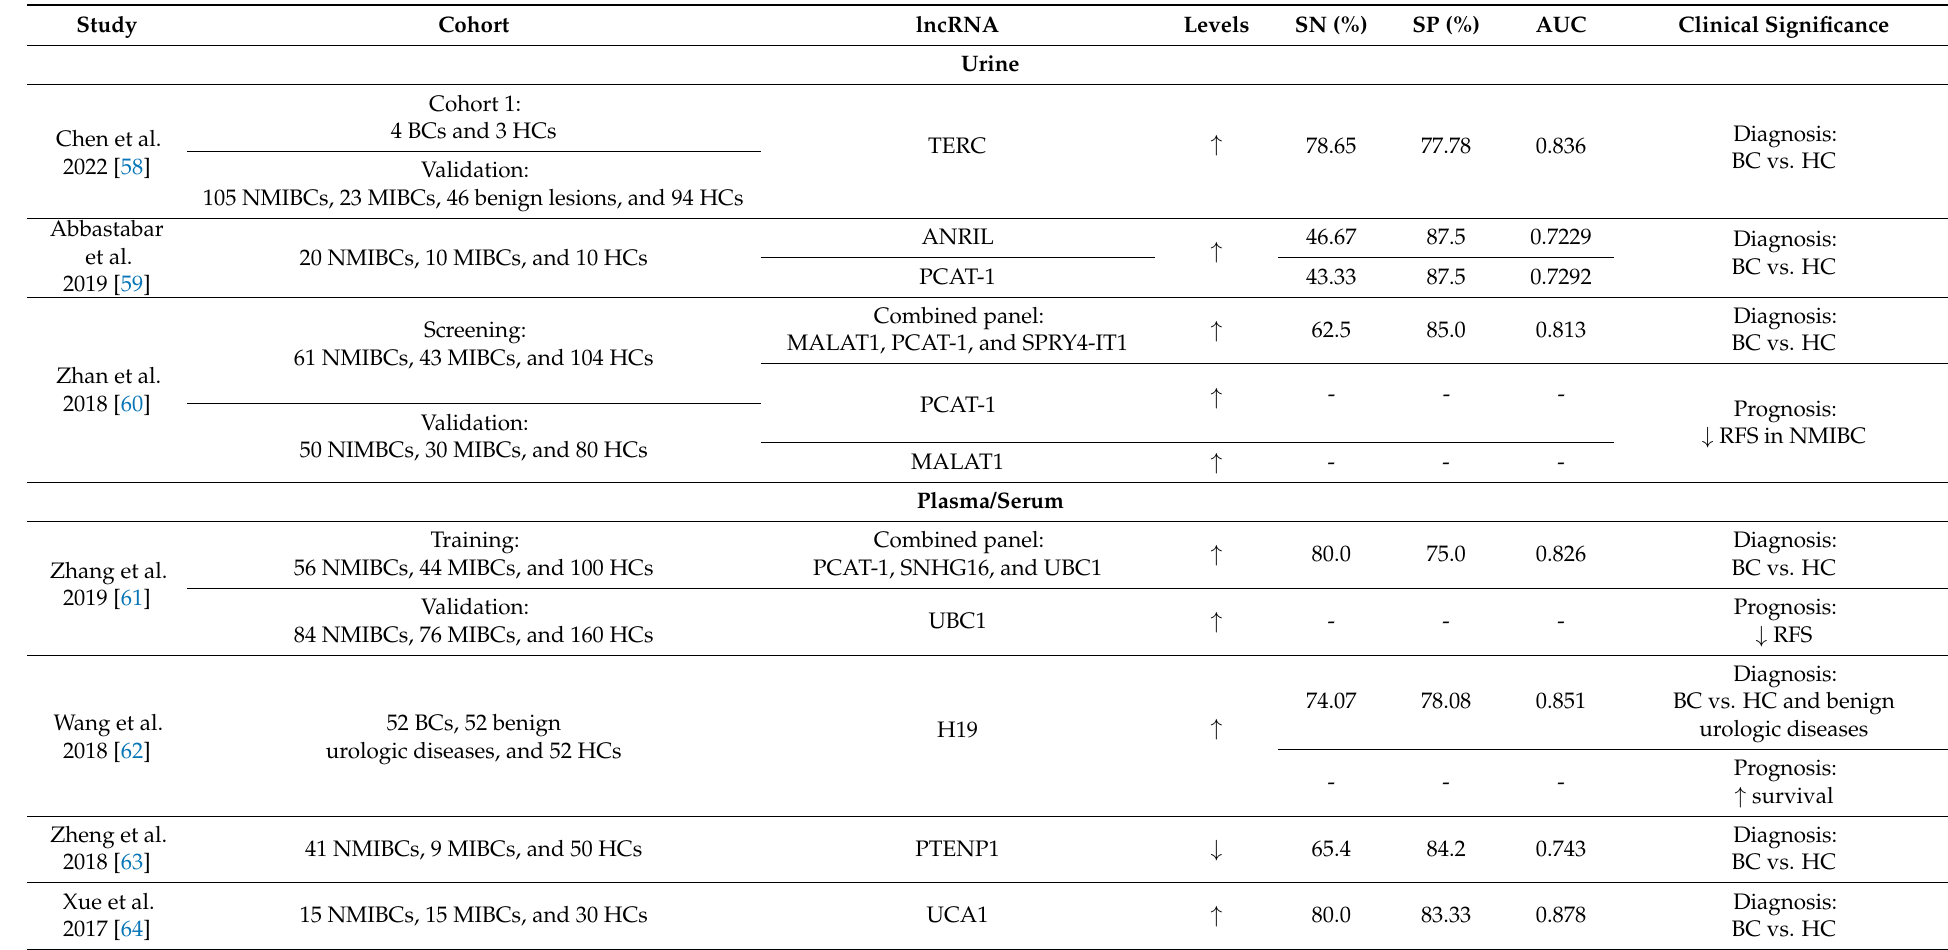
Table 2. lncRNAs with potential in the management of bladder cancer